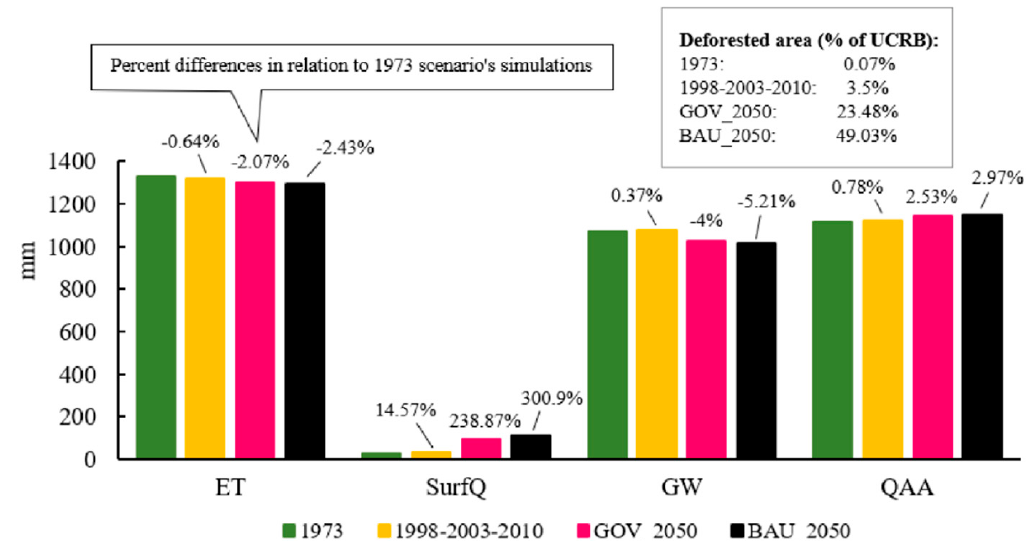
Figure 6. Annual average of the WBC in the UCRB and percent differences in relation to simulations with the 1973 scenario (baseline). SurfQ stands for surface runoff, GW is the groundwater, ET is the evapotranspiration, and Q AA is the average annual streamflow.